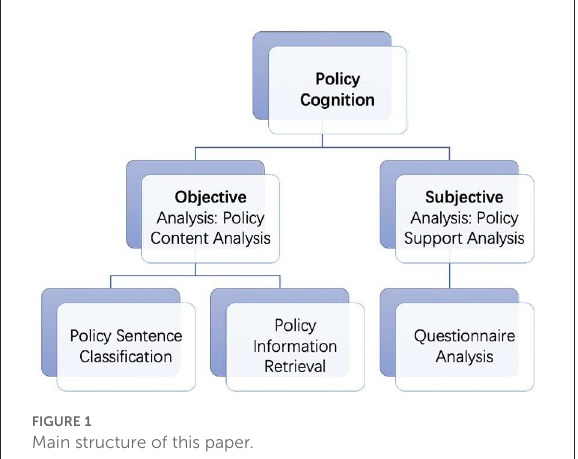
FIGURE1 Main structure of this